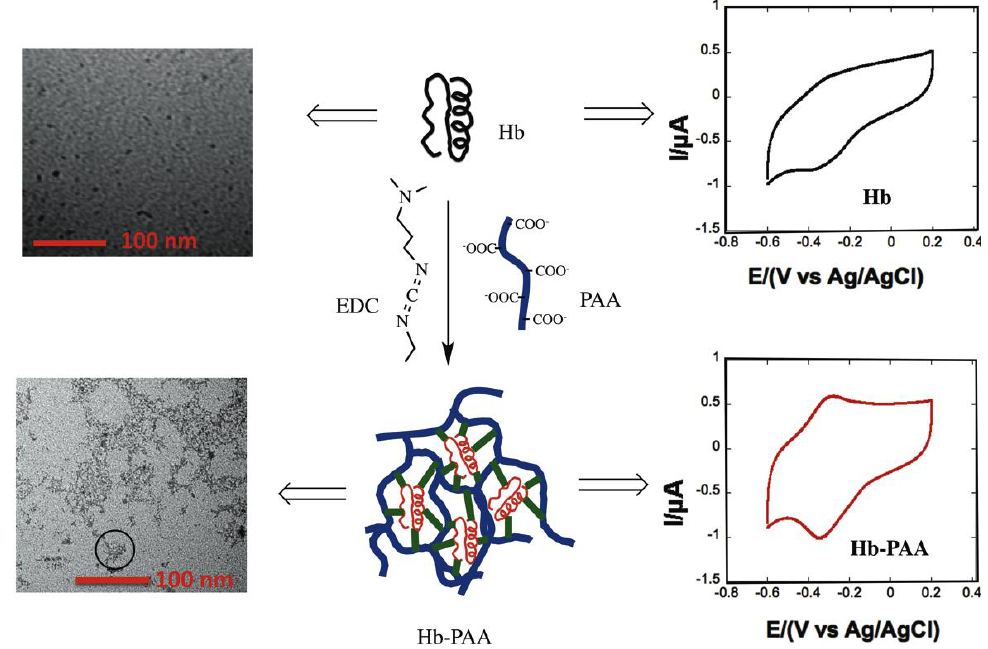
voltammograms ( Right ) and TEM’s ( Left ). TEM image of Hb-PAA shows the formation